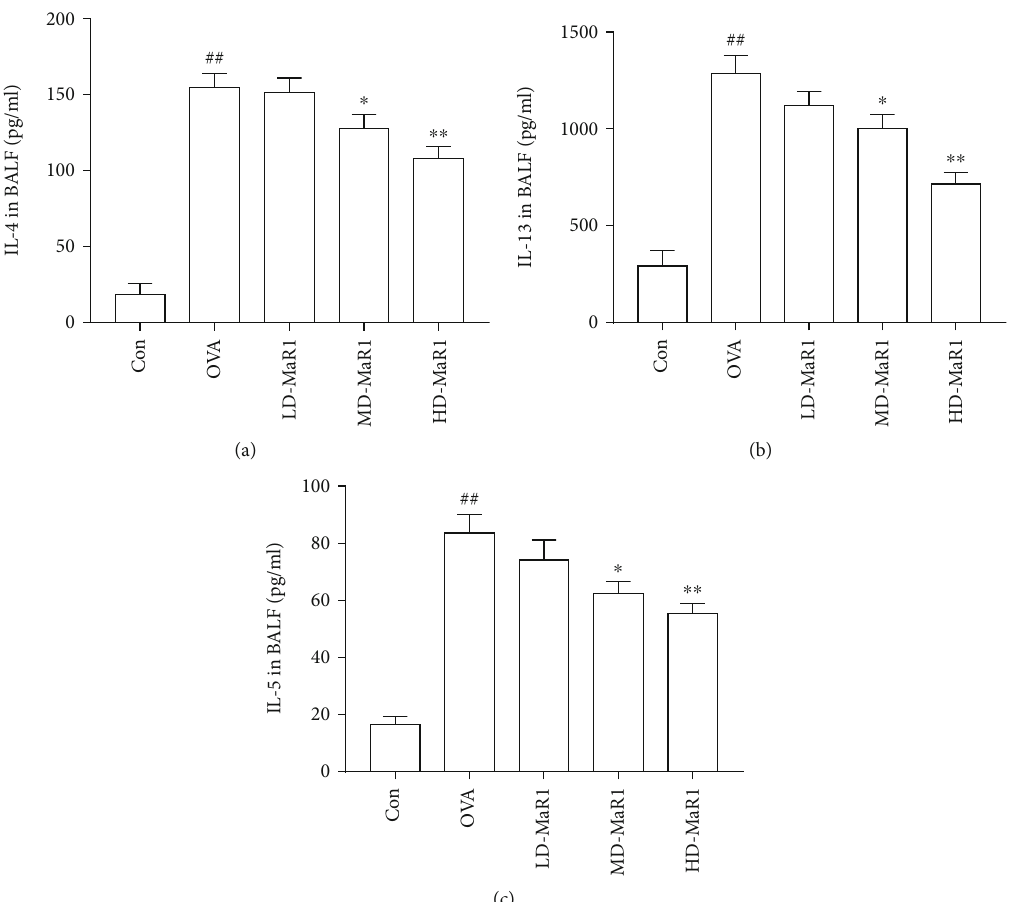
Figure 4: MaR1 treatment reduced OVA-induced Th2 cytokine levels in BALF. (a) IL-4 level in BALF. (b) IL-13 level in BALF. (c) IL-5 level in BALF. Data expressed as mean ± SEM ( n = 6/group ). # P < 0 : 05 , ## P < 0 : 01 vs. the control group; ∗ P < 0 : 05 , ∗∗ P < 0 : 01 vs.